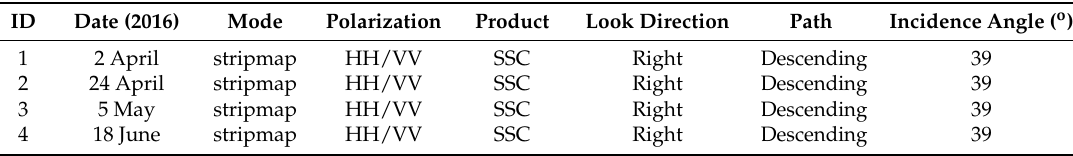
Table 1. Specifications of the four dual-polarization TerraSAR-X strip-map beam mode scenes used herein. VV—vertical linear transmission and vertical linear reception; HH—horizontal linear transmission and horizontal linear reception.